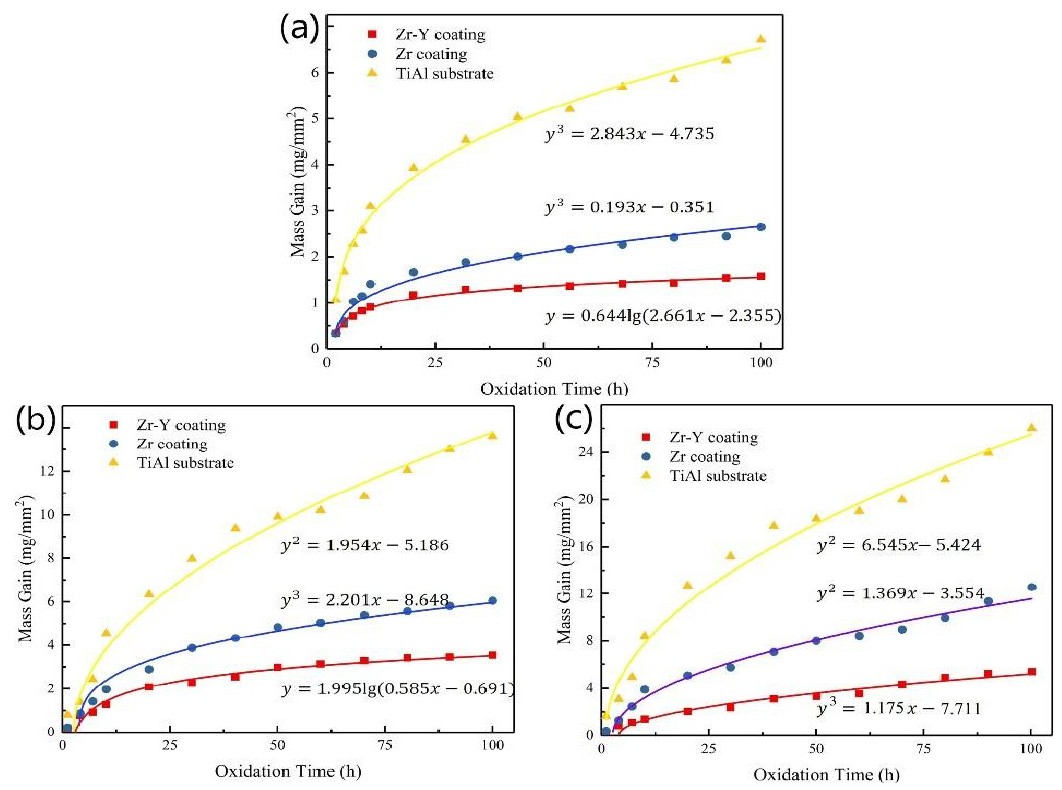
Figure 14. Oxidation kinetics of the specimens at ( a ) 750 °C; ( b ) 800 °C; ( c ) 850 °C.